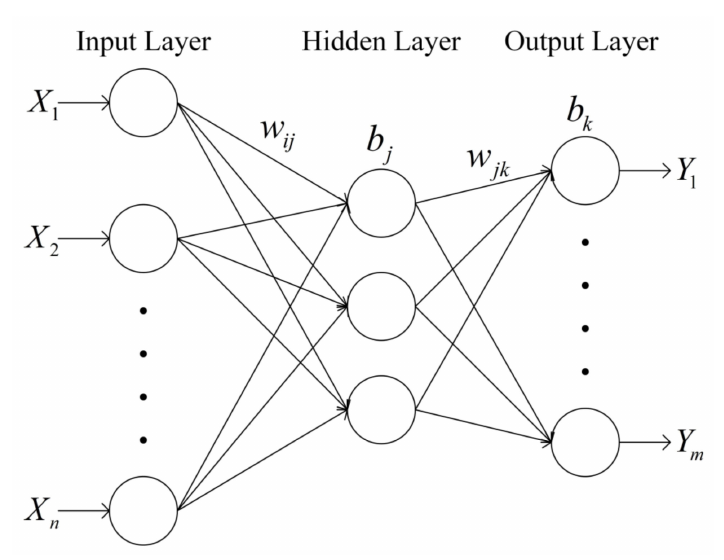
Figure 8. Basic structure of the BP neural